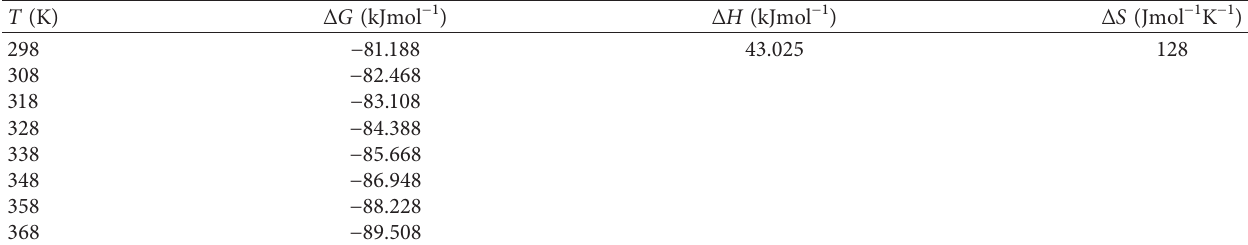
Table 3: Thermodynamic parameters for the adsorption of the BG dye onto AC.